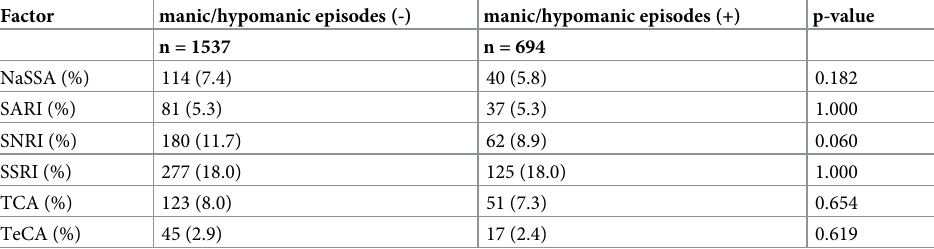
Abbreviations, NaSSA: Noradrenergic and Specific Serotonergic Antidepressant, SARI: serotonin antagonist and reuptake inhibitors, SNRI: Serotonin Noradrenaline Reuptake Inhibitor, SSRI: Selective Serotonin Reuptake Inhibitor, TCA: Tricyclic Antidepressants, TeCA: Tetracyclic